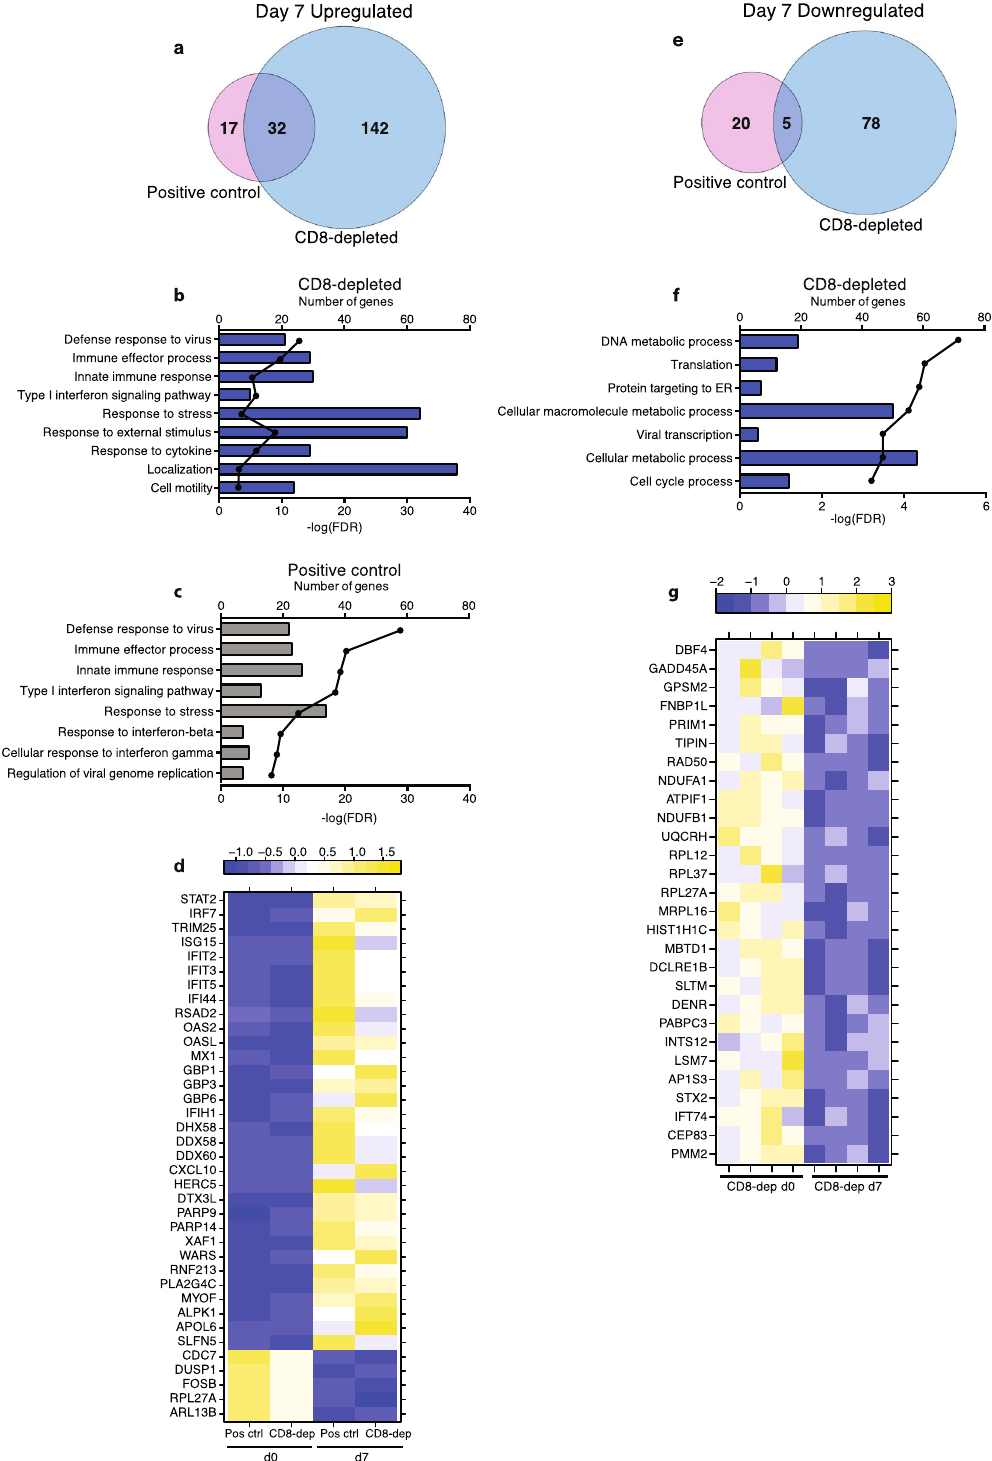
Figure 5. CD8 + T-cells play a role in rVSV-EBOV mediated protection. ( a ) Venn diagram of genes upregulated 7 dpi in positive control and CD8-depleted animals. ( b,c ) Bar graph depicting the most statistically significant GO terms enriched among up-regulated genes in CD8-depleted animals ( b ) and positive control animals ( c ) 7 dpi. ( d ) Heatmap of genes upregulated and downregulated in both CD8-depleted and positive control animals 7dpi; each column shows median transcript RPKM counts of all 4 animals in each group. ( e ) Venn diagram of genes downregulated in positive control and CD8-depleted animals 7 dpi. ( f ) Bar graph depicting the most statistically significant GO terms enriched among down-regulated genes in CD8-depleted animals 7 dpi. ( g ) Heatmap of all down-regulated genes, exclusive to CD8-depleted animals, mapping to all GO terms in ( f ) with a fold change cut off of 3; each column represents 1 animal in the CD8-depleted